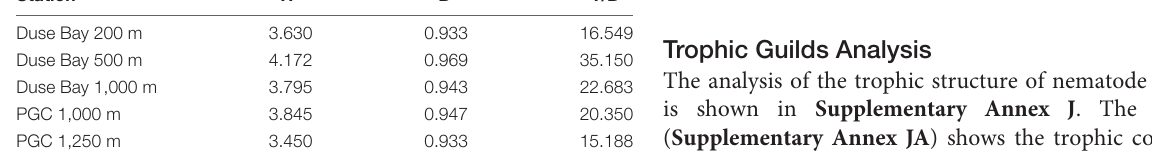
TABLE 5 | Significant values for biodiversity indexes: Shannon–Wiener (H (cid:48) ), Simpson (D), inverse Simpson (1/D) on the metabarcoding dataset (ASVs). Station H (cid:48) D